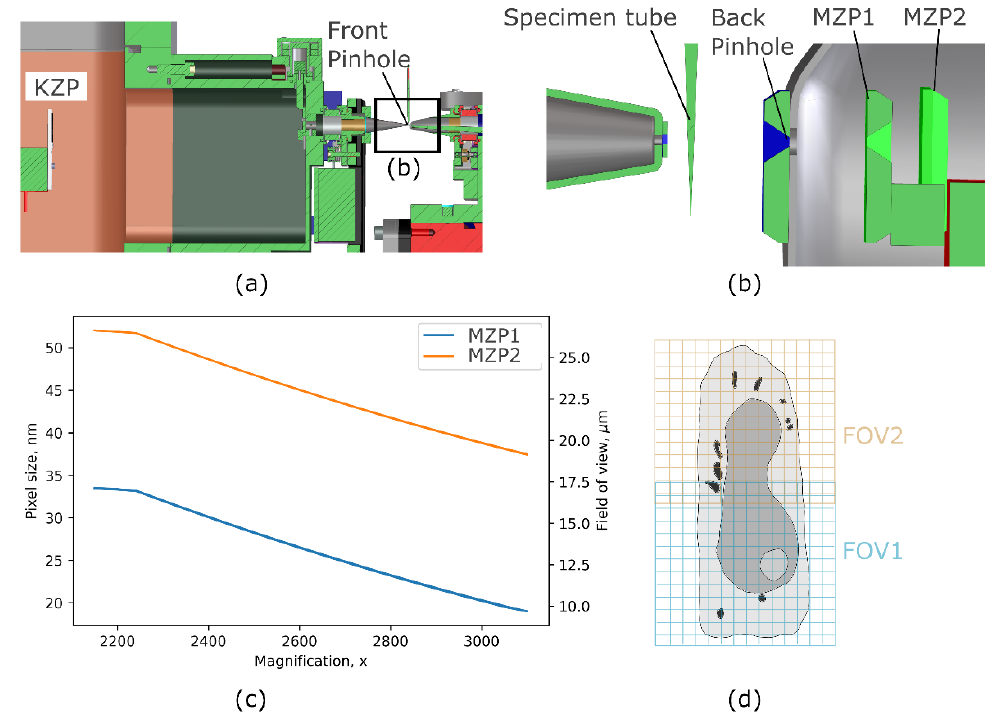
Figure 1. Schematics of soft x-ray microscope (XM-2). ( a ) Optical layout of the condenser zone plate (KZP), specimen tube, and objective zone plate MZP1 or MZP2 with 35 and 60 nm outermost zone width, respectively. ( b ) Magnification of specimen tube and multiple objectives installed at XM-2. ( c ) Pixel sizes in nm and the corresponding field of views in µm covered by two objectives in the SXT microscope with respect to magnification. ( d ) Acquisition strategy to overlay tomograms vertically for imaging larger cells inside the capillary.